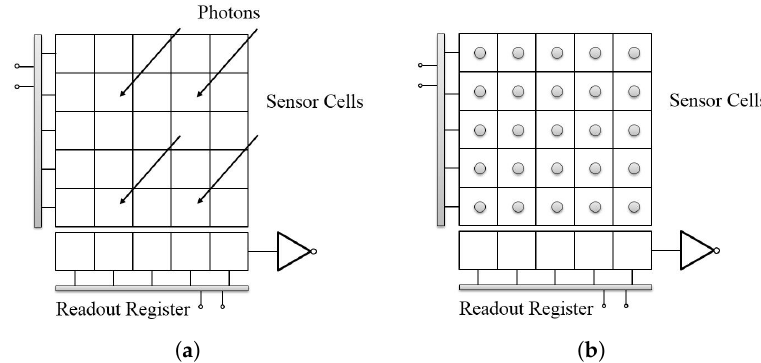
Figure 1. CCD (charge-coupled device) acquisition phase. ( a ) shows that the incoming photons fall on the sensor cells; and ( b ) shows that the photons are converted to electrical charges.